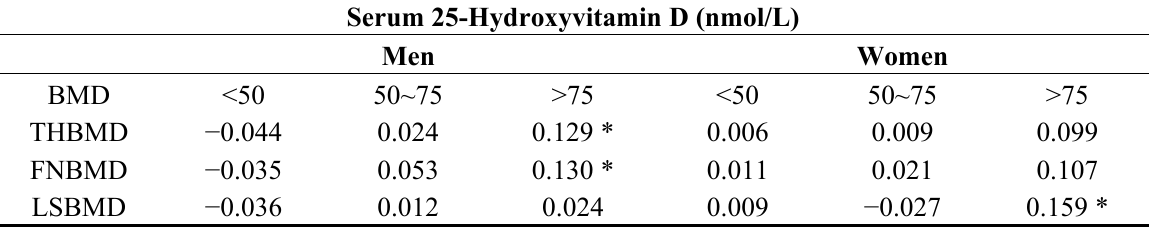
Table 2. Partial correlation of dietary vitamin A and bone mineral density by serum 25-hydroxyvitamin D